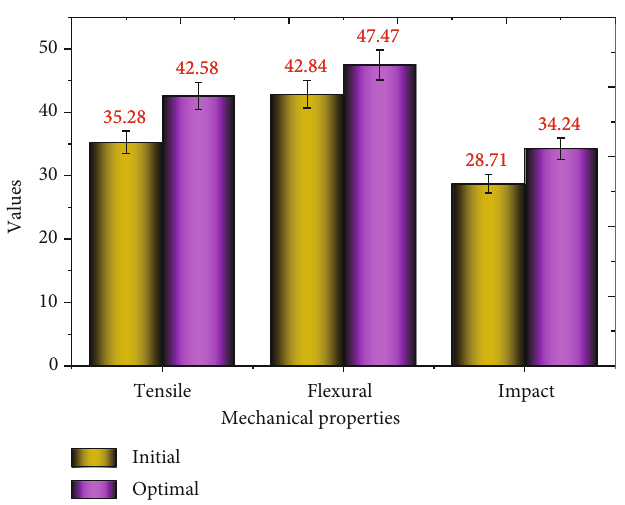
Figure 5: Comparison of initial and optimal parameters of mechanical properties. Table 8: Comparison of initial and optimal